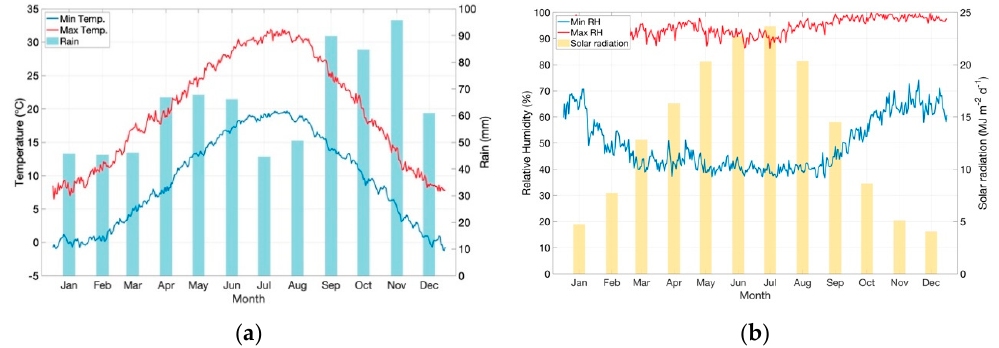
Figure 2. Average trends of agro-meteorological data registered at the Ponti sul Mincio station: ( a ) daily average values of maximum and minimum air temperature and monthly cumulate rainfall; ( b ) daily average values of maximum and minimum air humidity and monthly mean global radiation.